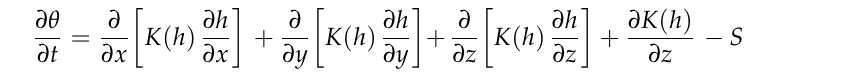
Figure 6. Computational region of water storage pit irrigation.